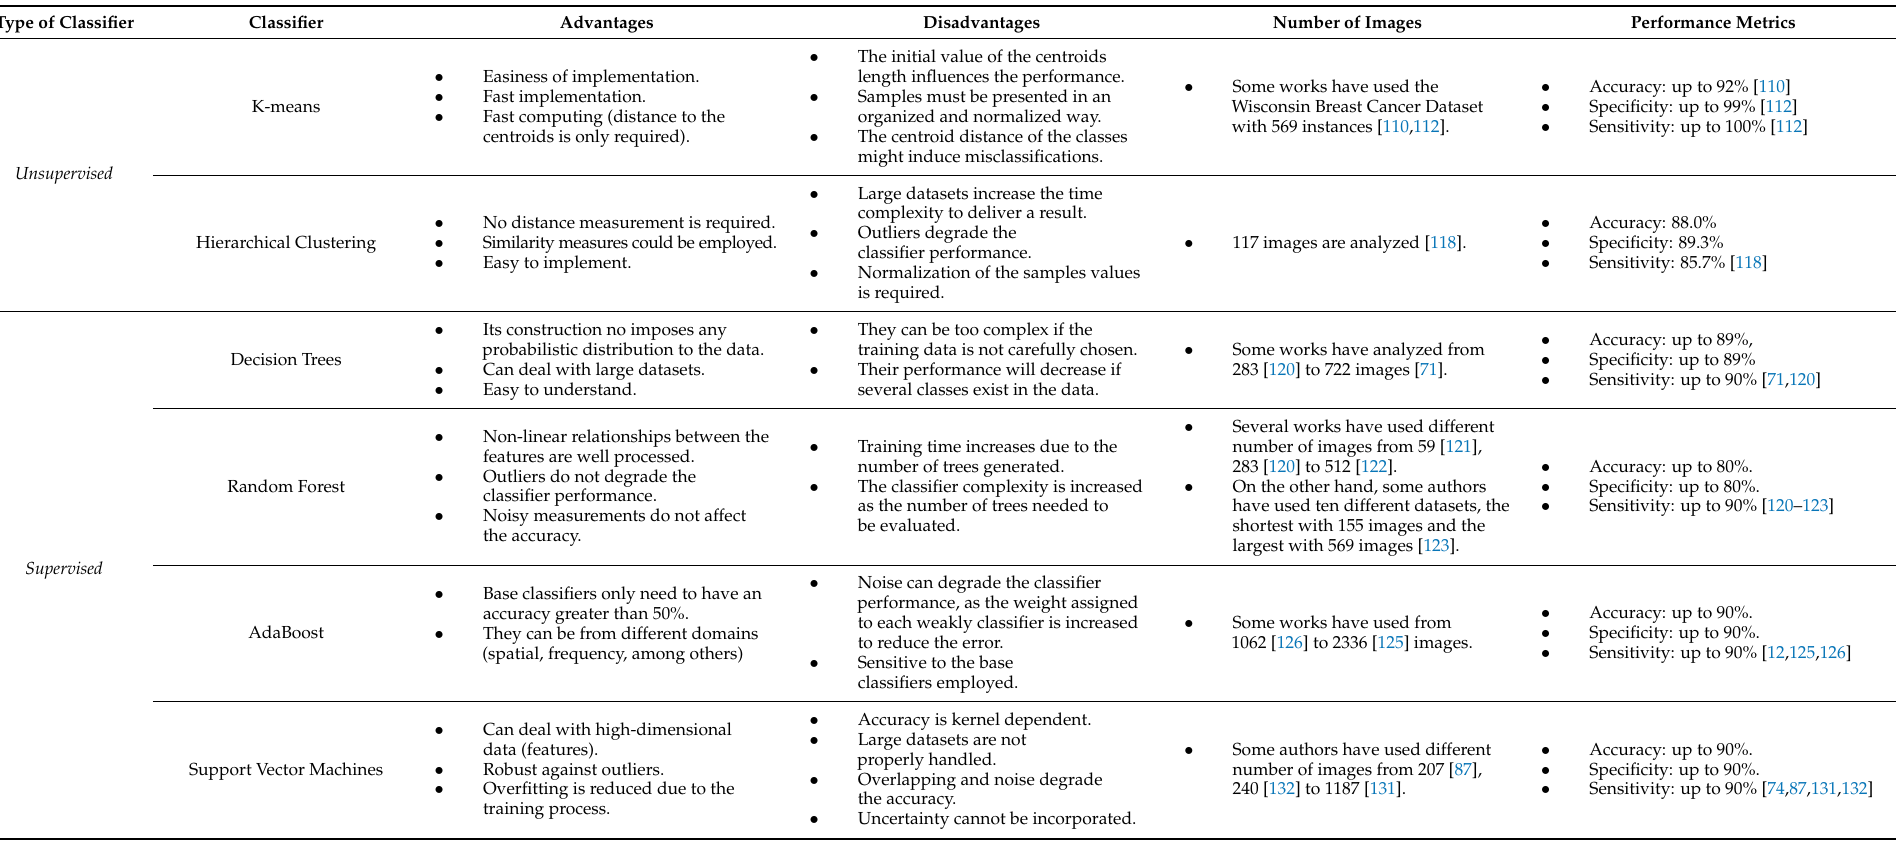
Table 2. Summary of the used image classification